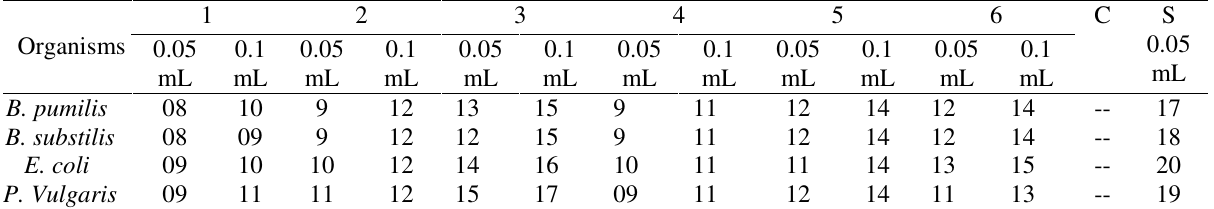
Table. 3. Antibacterial activity of chalcones (1-6)